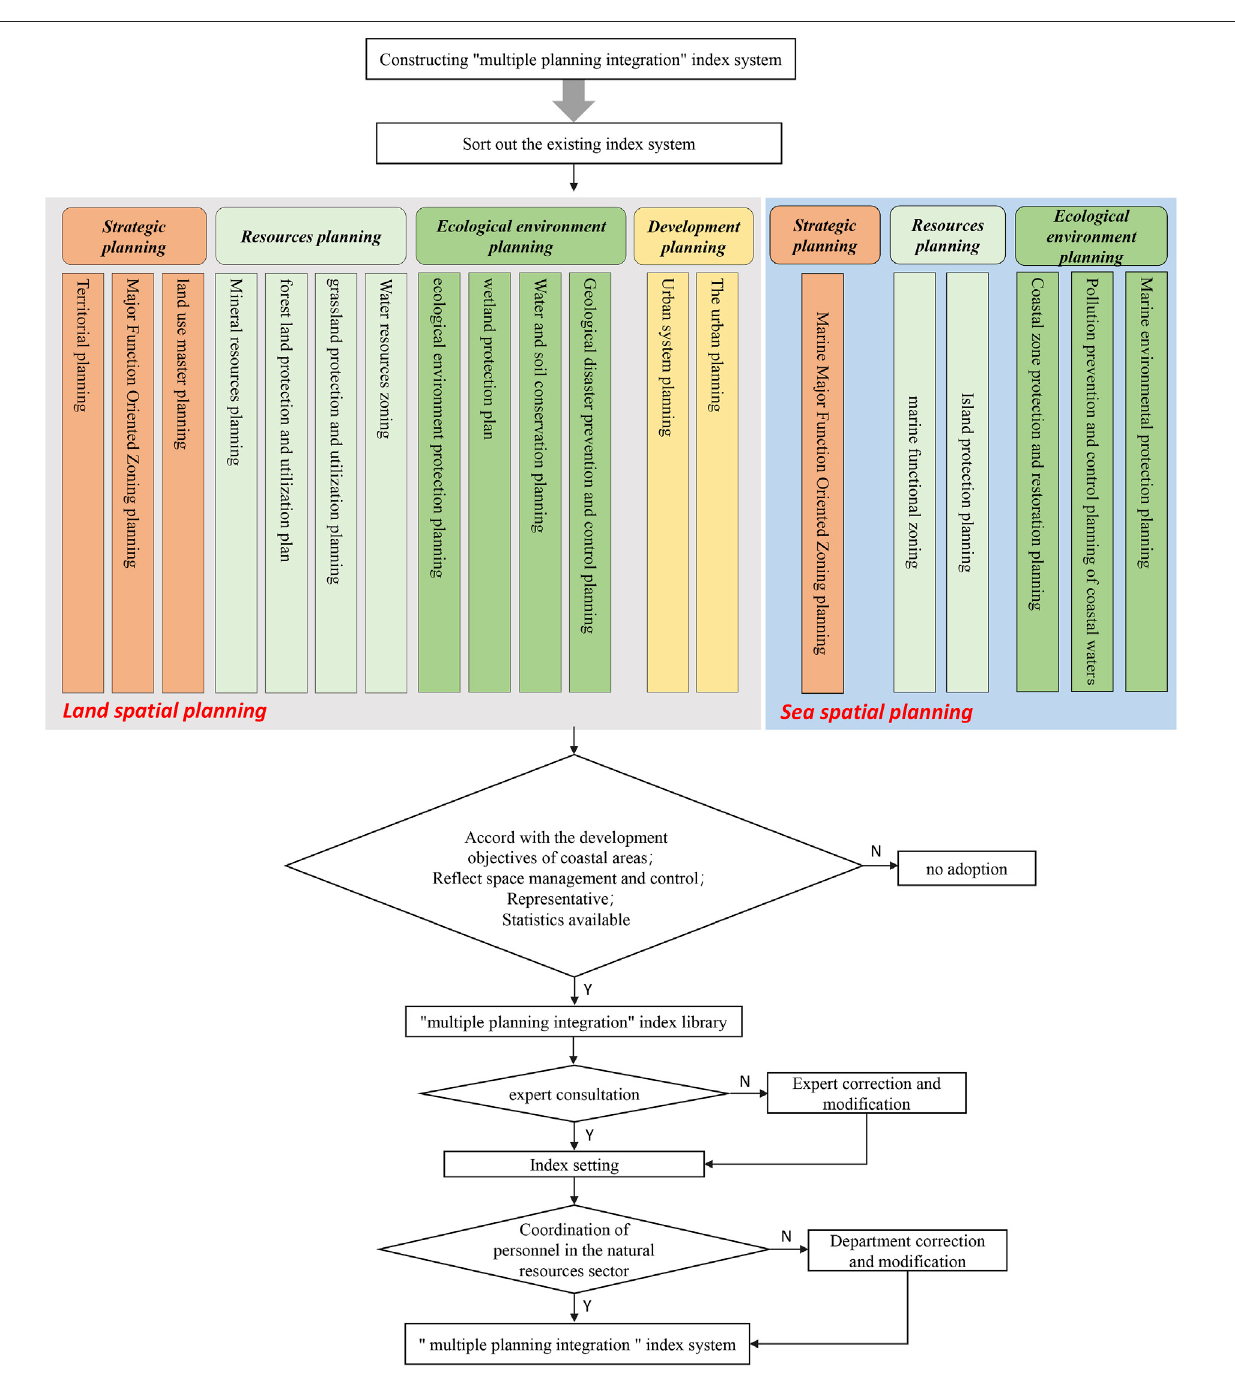
FIGURE 4 | Schematic diagram of the “ multiple planning integration ”